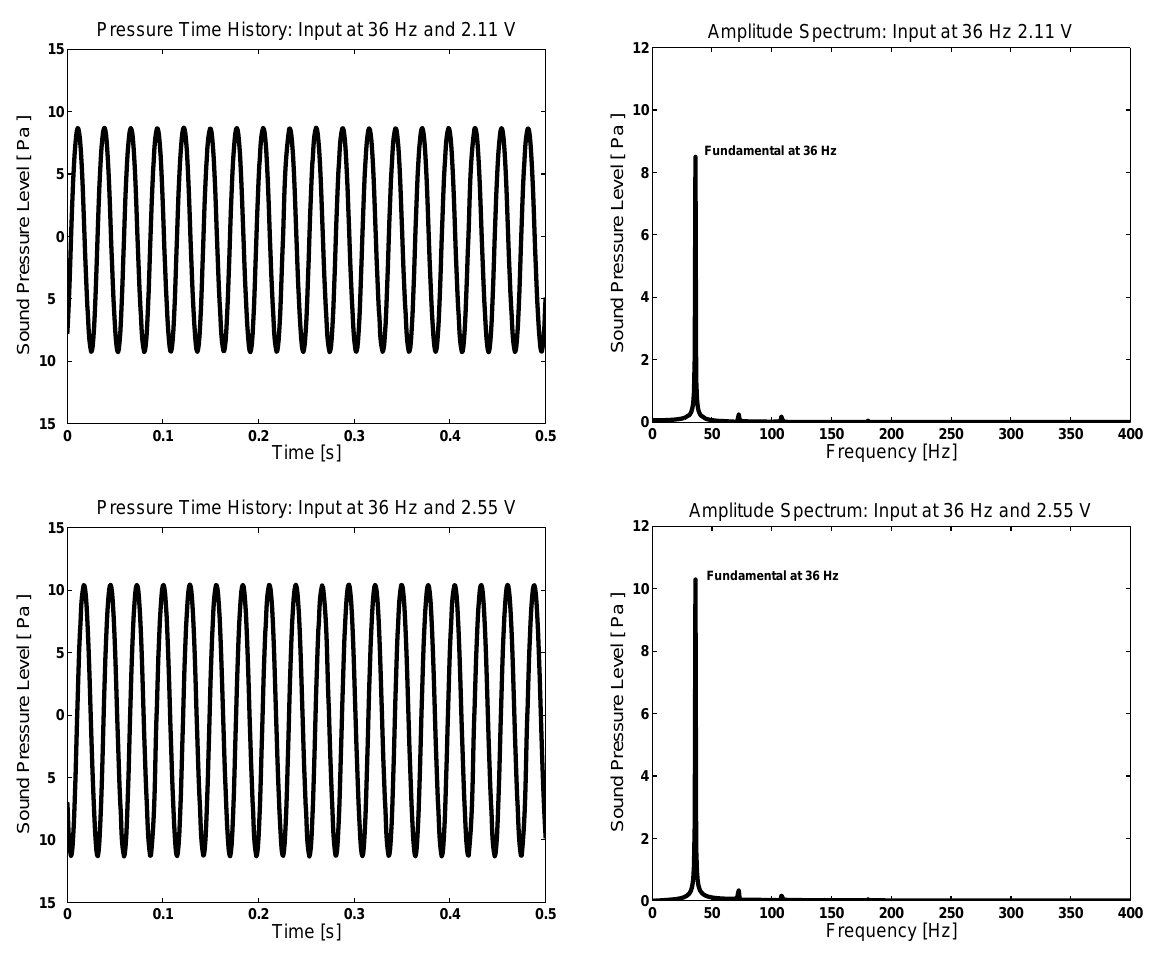
Fig. 10. Experimental measurements of the sound pressure level at input of 36